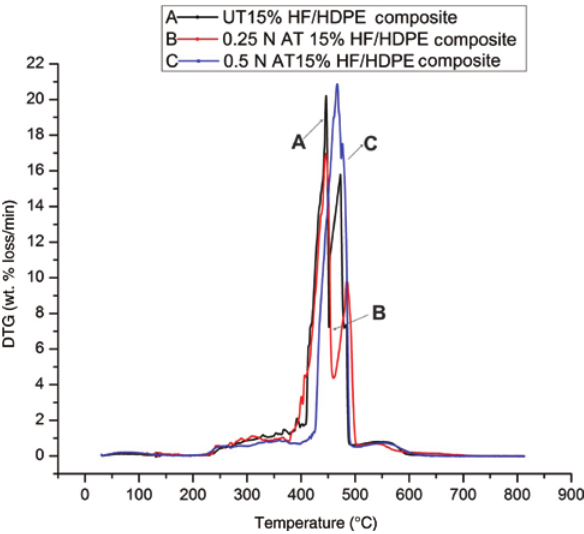
Figure 9: DTG thermograms of untreated and treated 15% HF/HDPE composites.